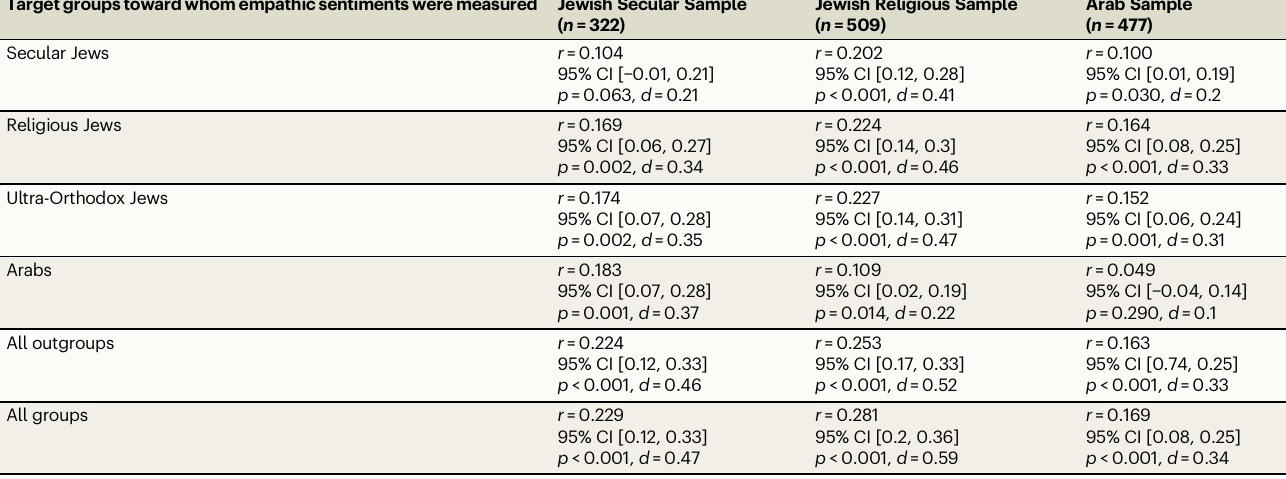
Table 1 | Simple correlations between belief about empathy asan unlimited resource and empathic sentiments toward ingroup and outgroups Targetgroupstowardwhomempathicsentimentsweremeasured Jewish Secular Sample ( n